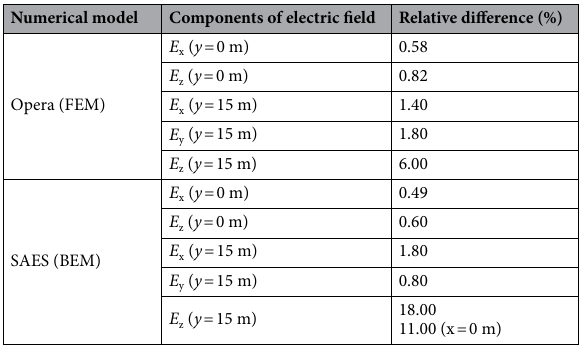
Table 5. Relative differences between results of the analytical (four-layer) model and numerical FEM and BEM models—Case II.